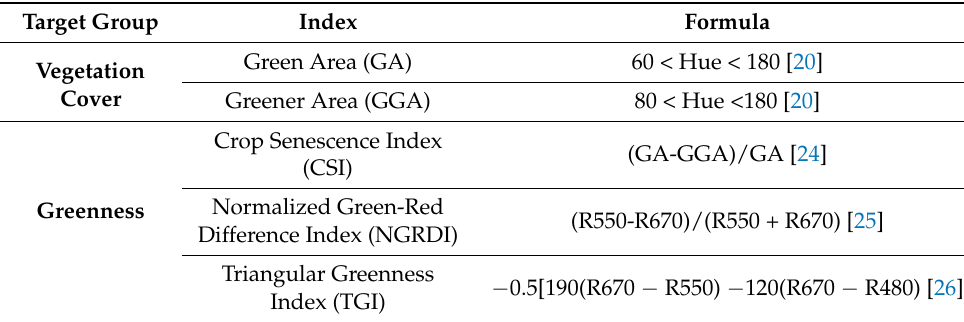
Table 2. Indexes derived from the RGB